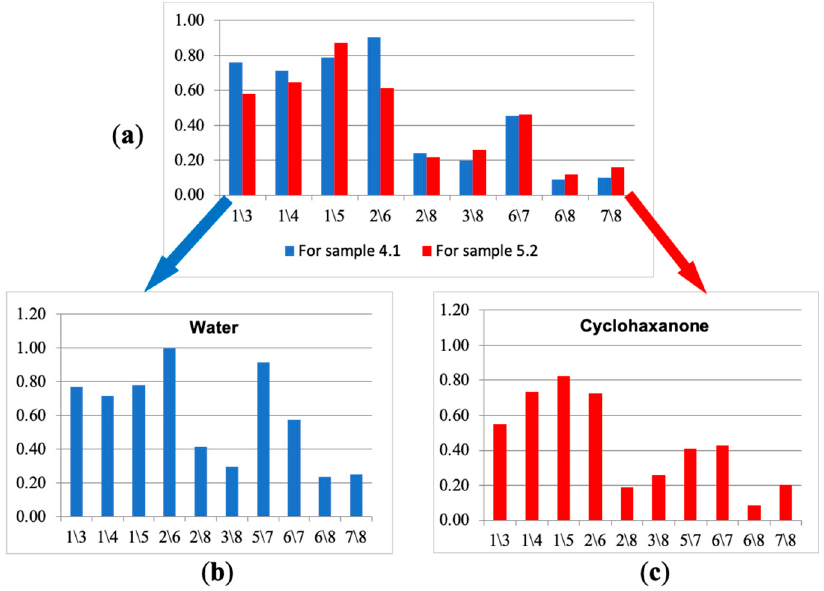
Figure 8. The truncated spectra of cross mass-sensitivity parameters for the gas phase over samples of nasal swabs: ( a ) water vapor ( b ) and cyclohexanone vapor ( c ).